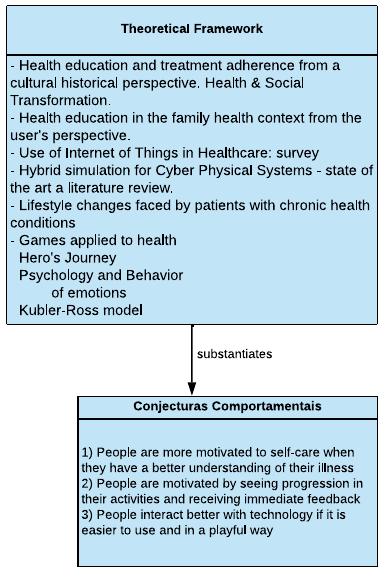
Figure 4. Theoretical framework and behavioral conjectures.